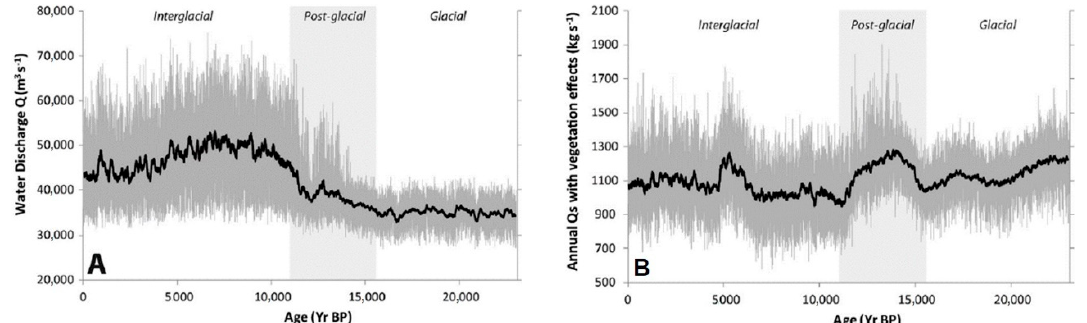
Figure 23. Water and suspended sediment simulation results focused over the last 23 ka. Gray curves represent annual data, while black curves are running means over 100 years. Three climatic periods (interglacial, post-glacial, and glacial) are individualized by the light gray / white bands in background. ( A ) Water discharge. ( B ) Mean suspended sediment load taking into account vegetation changes [121].